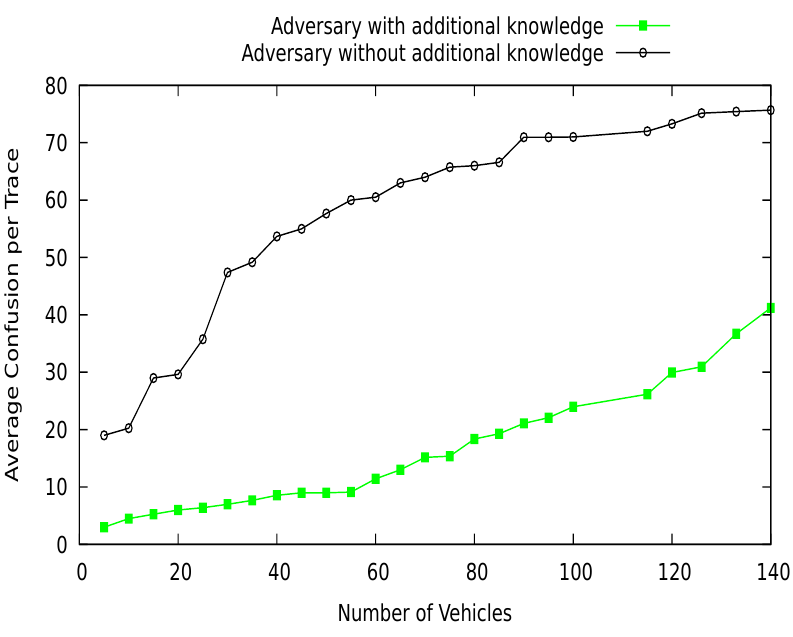
Figure 25. Adversary confusion in identifying vehicles on the